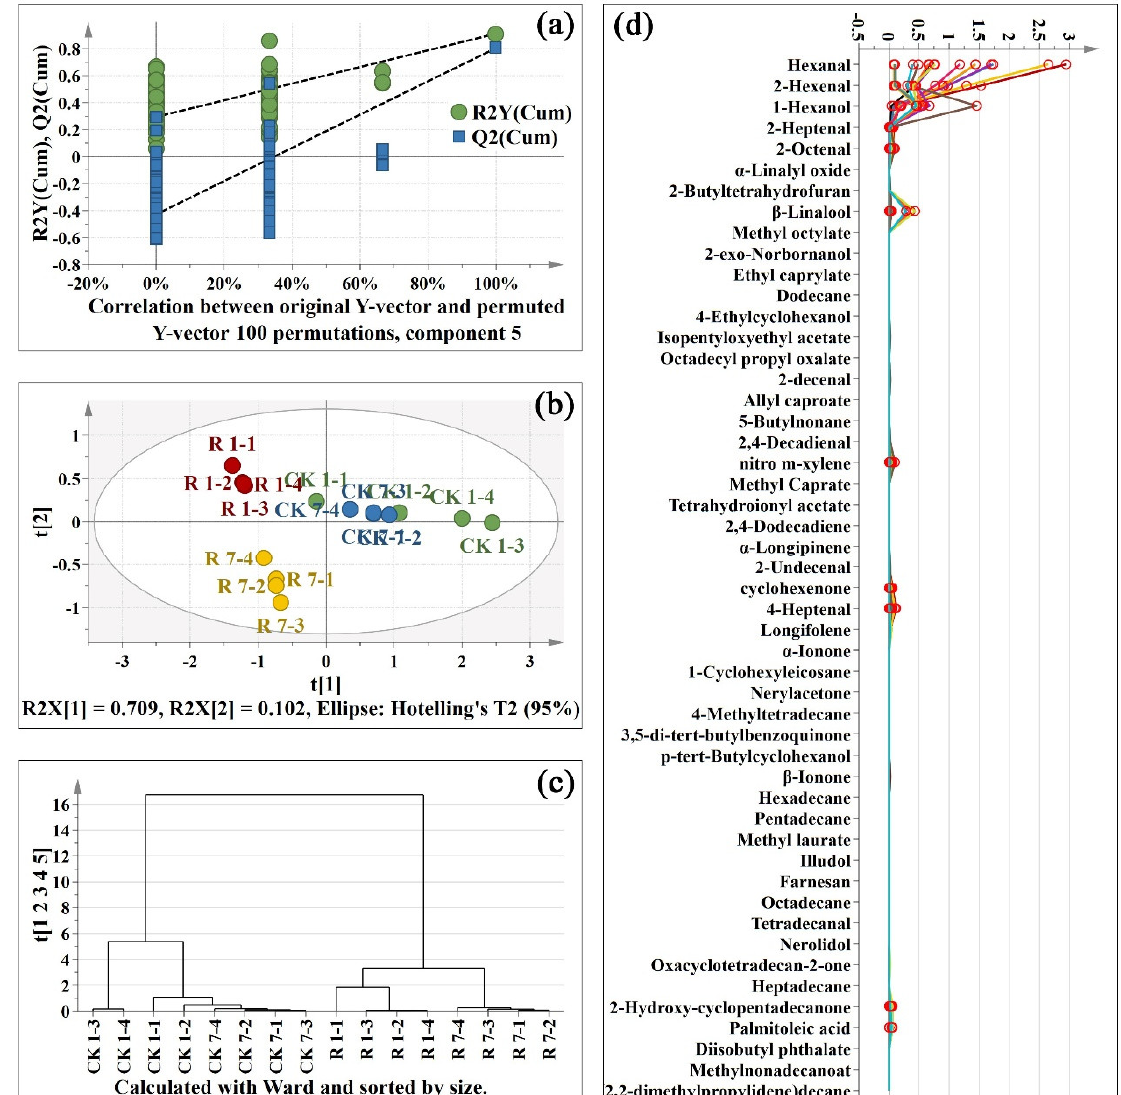
Figure 5. PLS-DA of volatile compounds after red light irradiation; ( a ): permutations plot of PLS-DA; ( b ): score scatter plot of PLS-DA. ( c ): HAC plot of PLS-DA; ( d ): spectra plot of PLS-DA. CK: control sample. R: red light. 1-1: one replicate of 1 d sample; 7–2: one replicate of 7 d sample. There are four replicates per sample. The key volatiles in OPLS-DA were marked in red circles in Figure 5d.